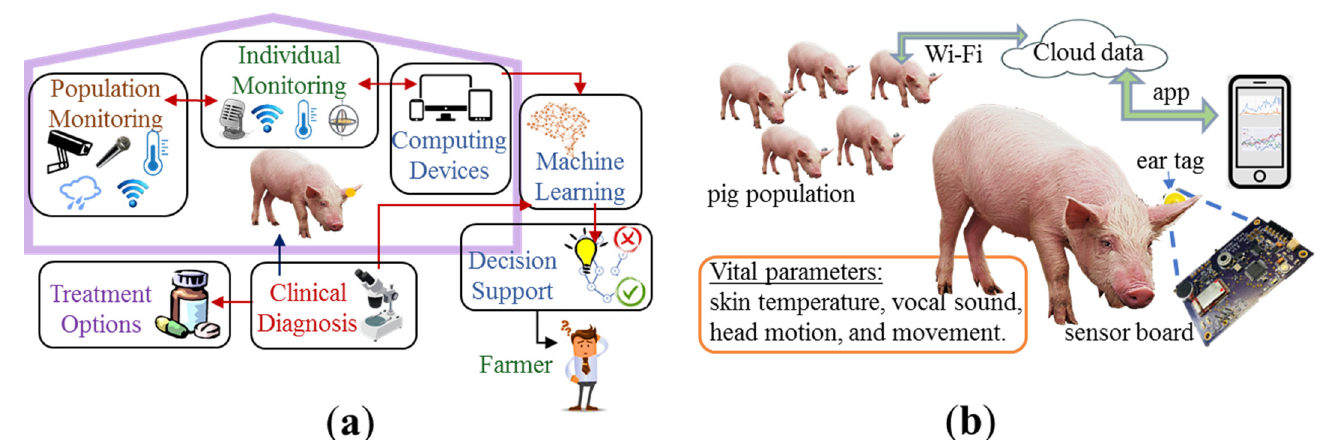
Figure 1. Overall theme for behavioral health monitoring in pig farms: ( a ) the pig farm is equipped with technologies to monitor individual animals and populations with mobile devices, data computing and storage units, machine learning, decision support tools, clinical diagnosis, and treatment options; ( b ) our measurement setup is shown. The ear tag with sensor board is attached to the ear lobe of individual pigs to measure vital parameters and send the data through a smartphone app to the cloud.